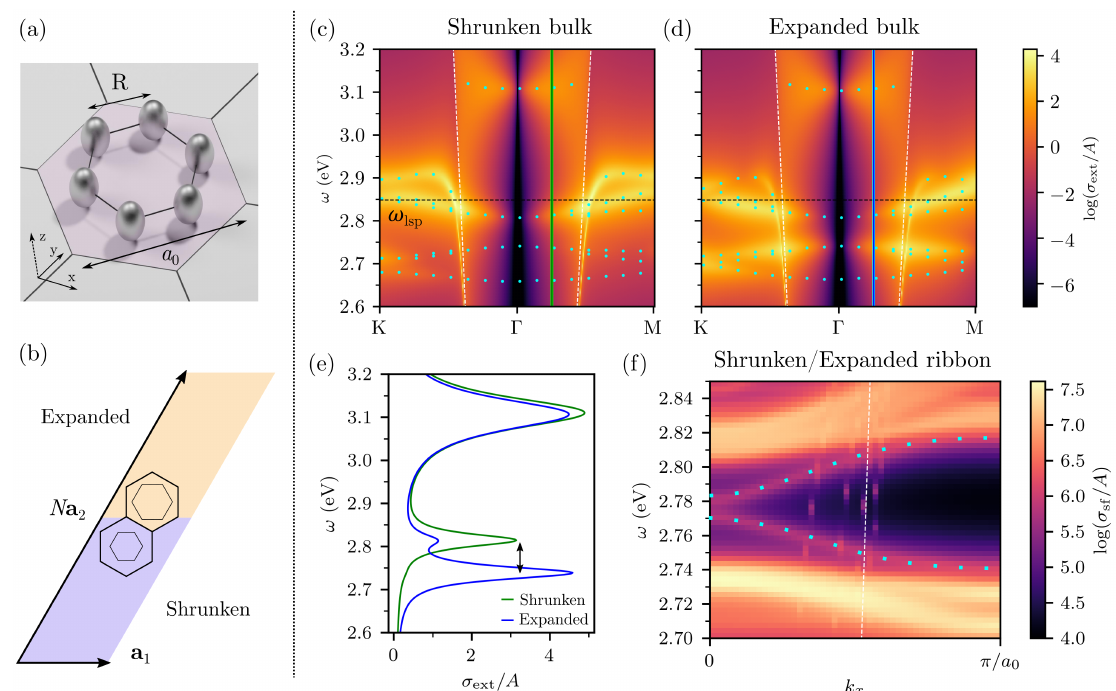
Figure 1. Lattice set up and optical response: ( a ) Unit cell with lattice vectors a 1 = ( a 0 ,0 ) and √ a 2 = ( a 0 /2, 3/2 a 0 ) , the lattice constant a 0 = 120 nm. The honeycomb lattice has nearest neighbour spacing R = R 0 = a 0 /3. The expanded lattice has R = 1.065 R 0 and the shrunken lattice R = 0.9 R 0 . ( b ) Ribbon interface between expanded (orange) and shrunken (blue) regions. The ribbon is doubly periodic, with lattice vectors a 1 and N a 2 . The total ribbon length is N = 20, with 10 expanded and 10 contracted unit cells. Extinction cross sections σ ext for ( c ) shrunken and ( d ) expanded lattices. The band structures, found from the spectral function, are highlighted in blue. ( e ) σ ext for the shrunken and expanded lattices at k (cid:107) , shown in ( c,d ) (Green and blue vertical lines). A band inversion occurs near Γ , causing the dipolar band to switch with the quadrupolar band (arrow). ( f ) Spectral function σ sf for the ribbon interface in ( e ). Drude losses are γ = 10 meV to increase the visibility of the edge states and they are highlighted (blue